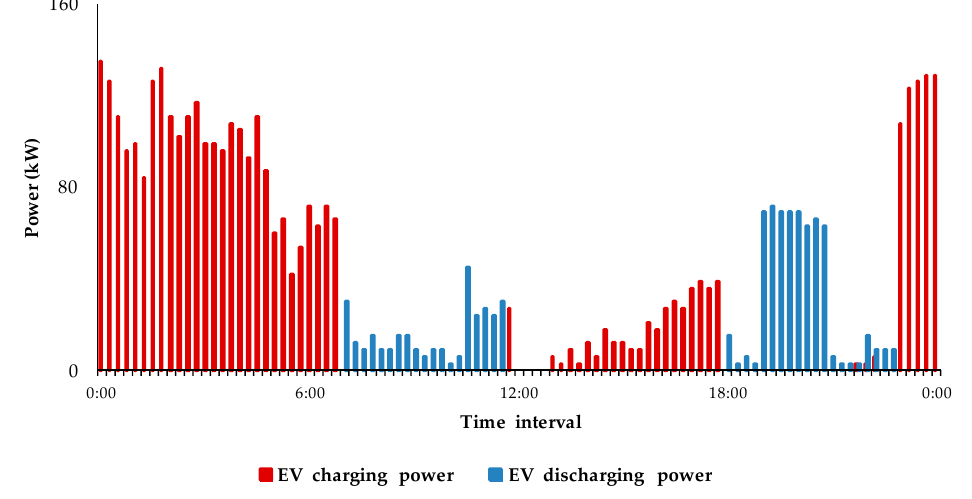
Figure 5. Daily charging and discharging power curves of EVs on a typical day.